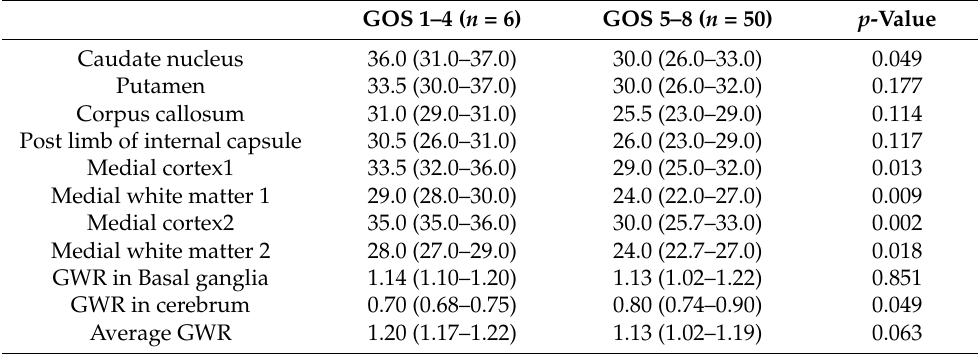
Table 4. Comparison of absolute attenuation in Hounsfield units and grey/white matter ratio between better neurologic outcome and poorer neurologic outcome.